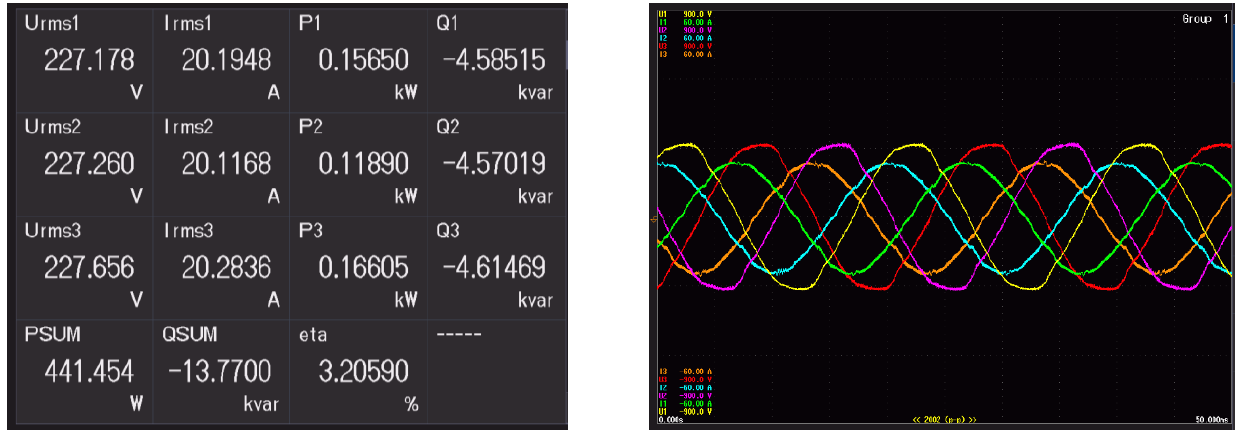
Figure 10. Exemplary results for power losses measurement from power analyzer WT5000.